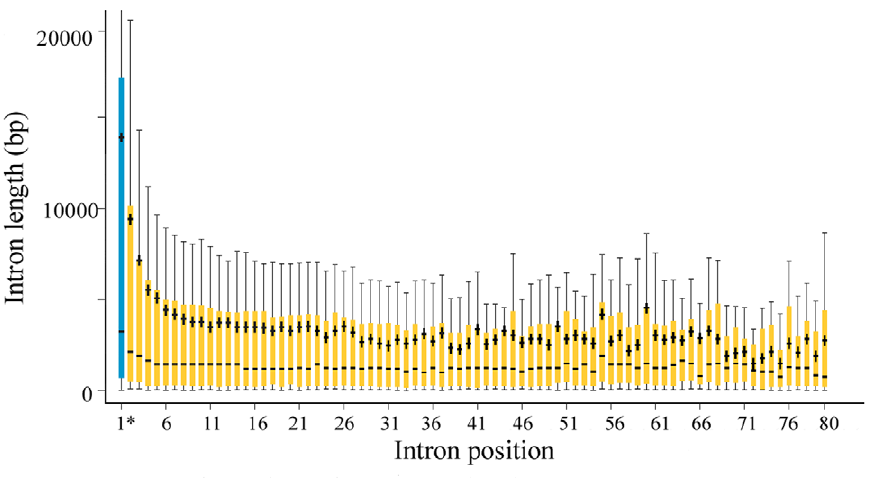
Figure 1. Characteristic lengths of the introns. The bottom and top of the box is the 25 th percentile (the lower quartile) and 75 th percentile (the upper quartile) of lengths, respectively; the line in the box is the 50 th percentile (the median). The lowest and highest datum is the minimum and maximum not considered outliers, respectively, and outliers are not plotted. ‘ + ’denotes average length of introns with the same position. ‘*’ denotes that the maximum length of the first introns is more than 20000 bp which is not displayed in figure. The situations of introns whose position beyond 80 are not shown since the numbers of sequences are less than 30, hereinafter.